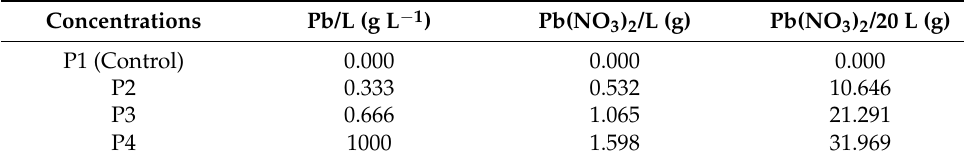
Table 3. Solutions per liter.